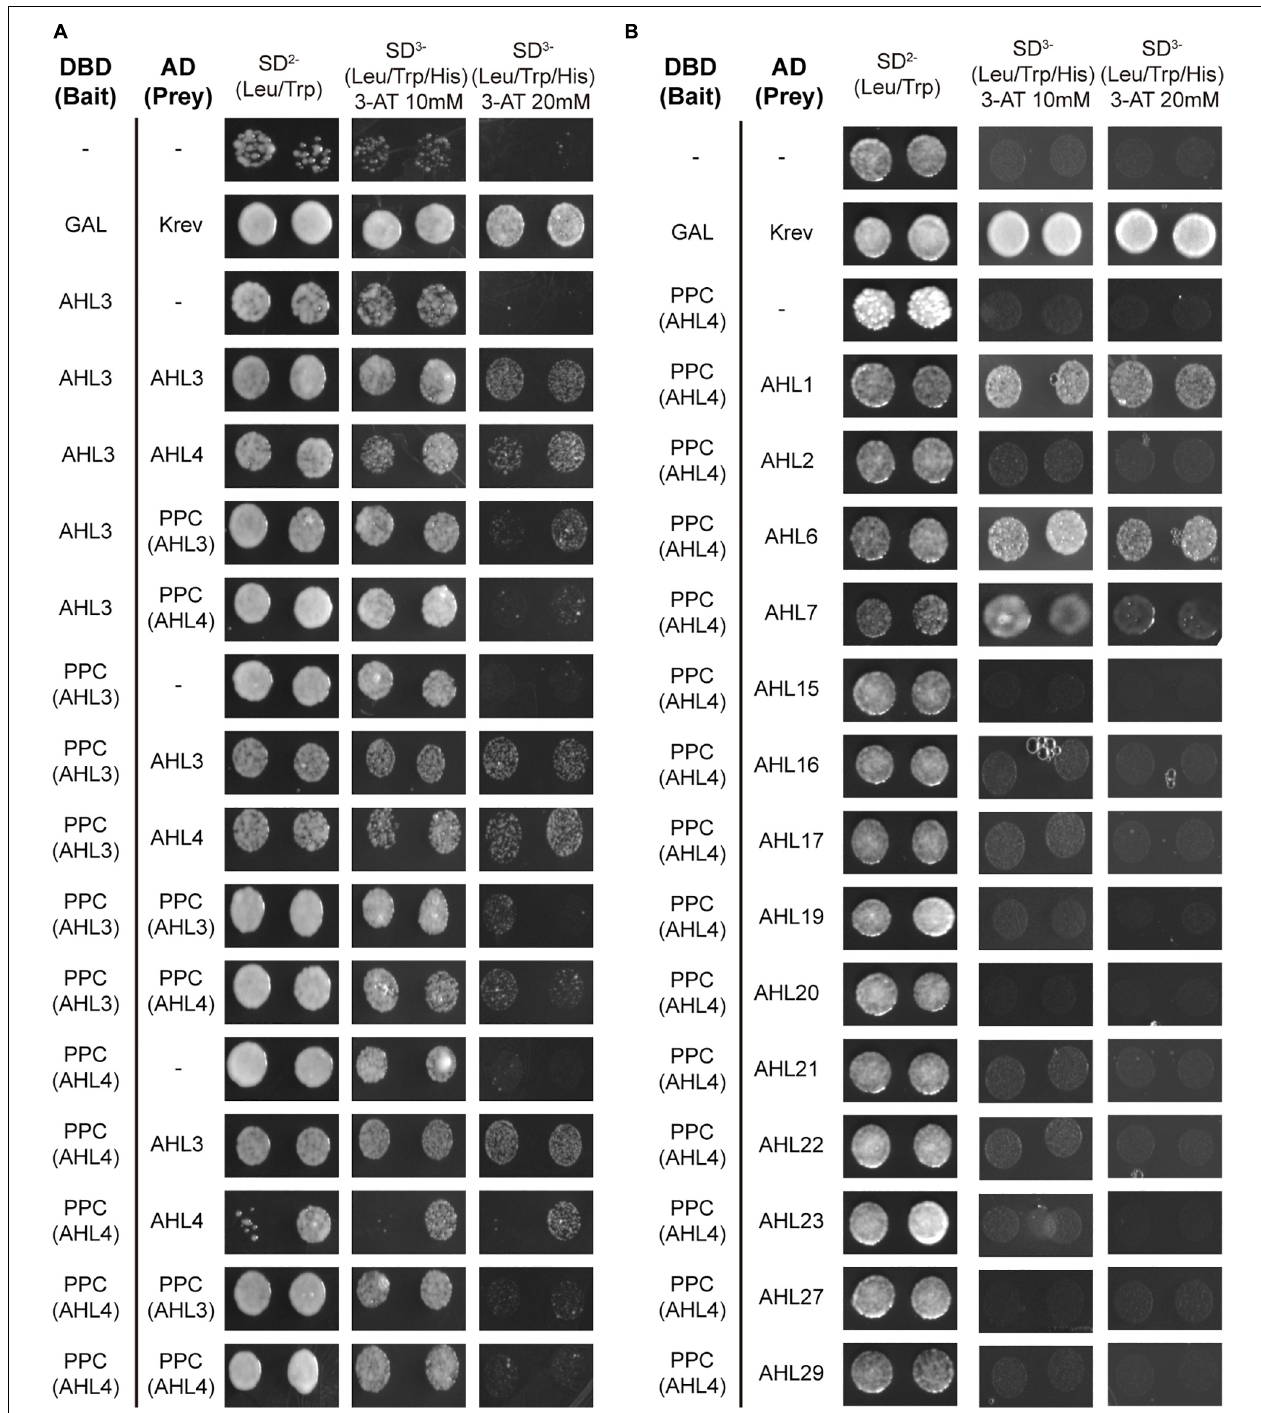
FIGURE 2 | Plant and prokaryotes conserved (PPC) domain of AHL4 mediates protein–protein interaction specific to clade B AHLs. (A) Analysis of the PPC domain of AHL3 and AHL4 in the protein–protein interactions using yeast two-hybrid assays. (B) Analysis of the PPC domain of AHL4 during interactions with other AHLs using a yeast two-hybrid assay. Left column, a pair of interactors; upper row, series of selection media. DBD (bait), DNA-binding domain; AD (prey), activation domain.